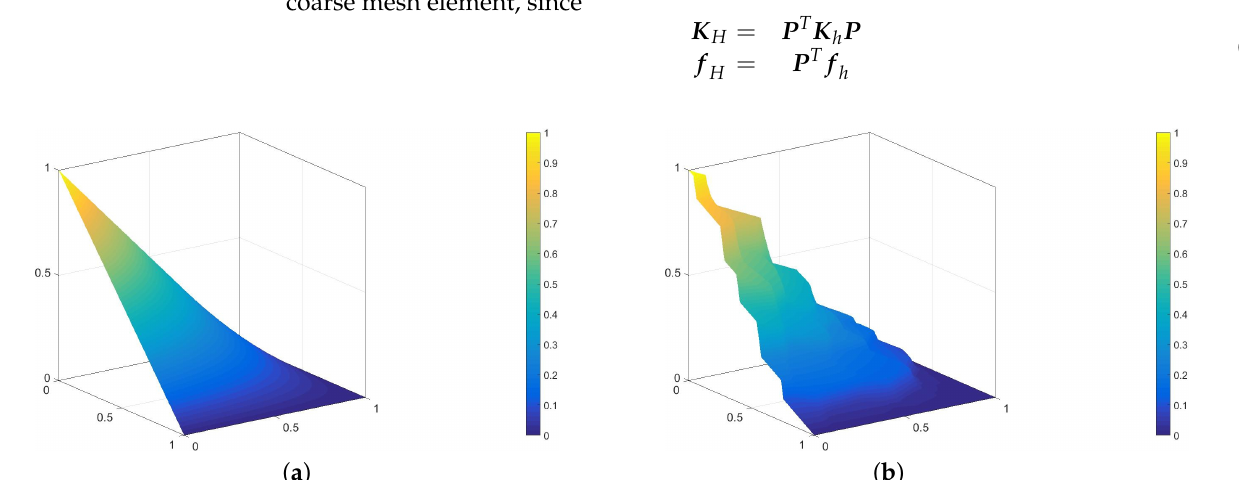
Figure 1. Exemplary bilinear standard ( a ) and modified ( b ) shape functions for the unit square coarse element.